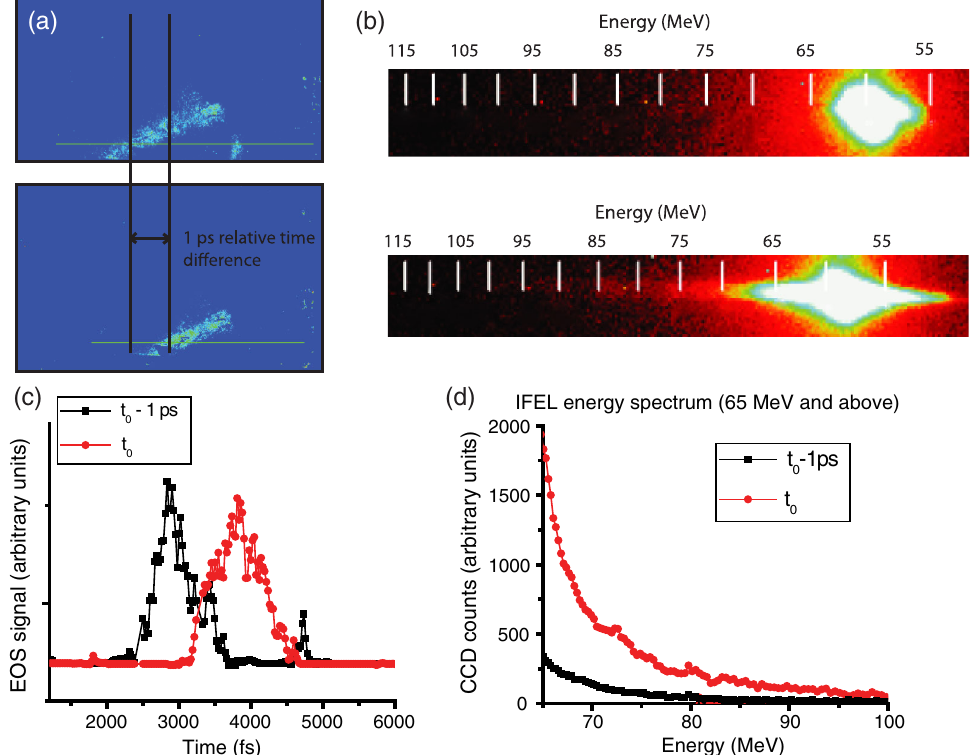
FIG. 7. Coincident EOS images and raw IFEL spectrum images (a and b). Temporal profile of the EOS signal (c) and lineouts of the spectrum images for > 65 MeV electron energy.